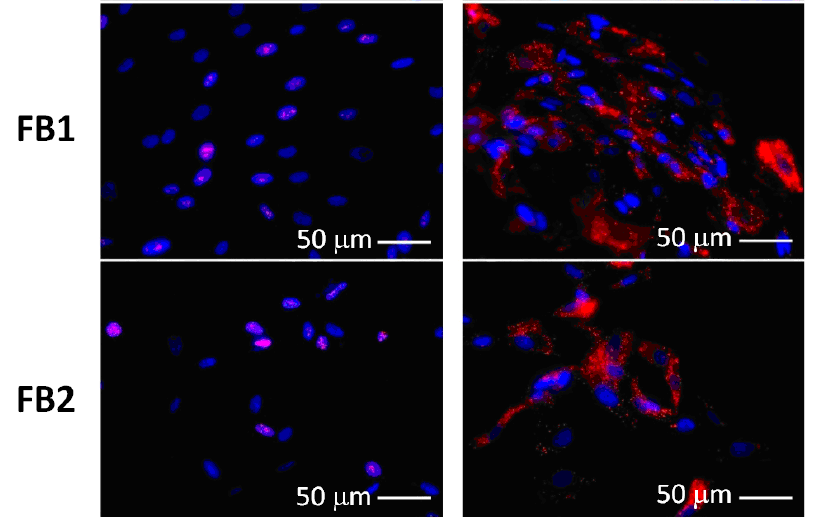
Figure 8. Evaluation of the rate of proliferating cells for UC MSCs ( left ) and cell morphology ( right ).